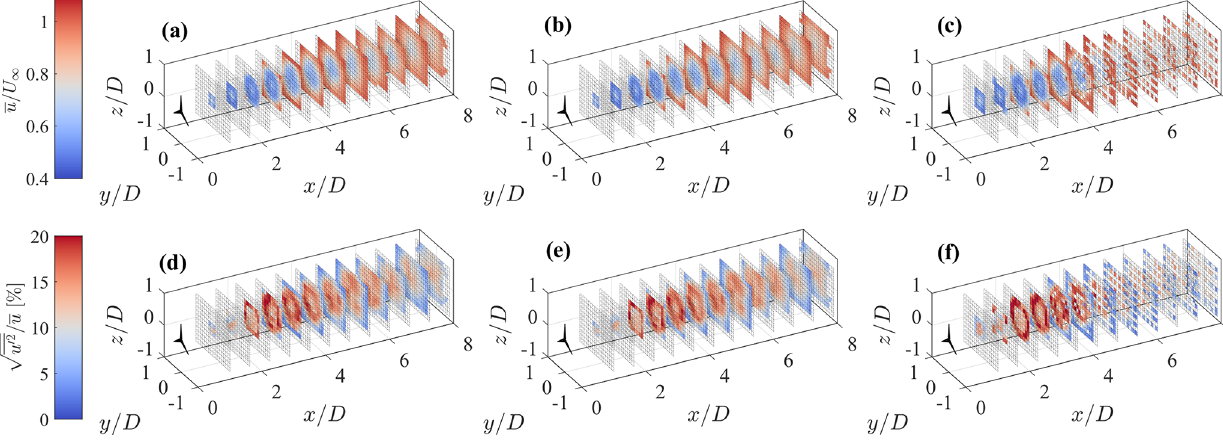
Figure 20. Statistics retrieved from a step-stare virtual lidar scan of the LES data set by means of different techniques. (a, d) Delaunay triangulation. (b, e) Linear interpolation. (c, f) Window averaging. (a, b, c) Mean streamwise velocity. (d, e, f) Streamwise turbulence intensity.